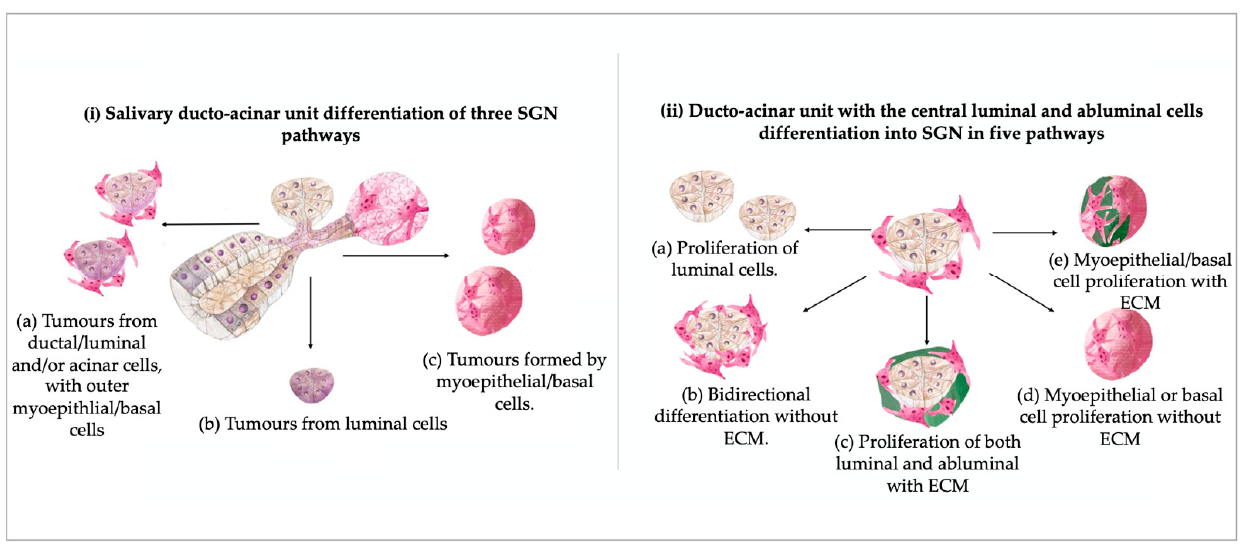
Figure 2. Schematic representation of the pathogenesis of SGN. ( A ) Histogenic concepts. ( B ) Morphogenic concepts. Reprinted from [2,5,6,13] with permission. Figure 2A depicts the four histogenic concepts that emphasize reserve cells of the salivary gland that replicate pathologically to form SGN (the cell type is highlighted in red for each theory): (i) Basal reserve cell theory–basal cells of excretory and intercalated ducts; (ii) pluripotent unicellular reserve cell theory–basal cells of the excretory duct; (iii) semi-pluripotent bicellular reserve cell theory–basal cells of the excretory duct and intercalated duct; (iv) multicellular theory–all mature acinar and basal cells. Figure 2B highlights the morphogenic concept that emphasizes the differentiation process and arrangement of tumor cells in SGN development: (i) Salivary ducto-acinar unit showing potential for differentiation of three SGN pathways: (a) tumors arising from combination of ductal/luminal and/or acinar cells, with outer myoepithelial/basal cells; (b) tumors mainly originating from luminal cells that may differentiate into non-specific ductal, acinar or goblet cells, and/or combination of these cells; (c) tumors almost entirely formed by myoepithelial/basal cells; or (ii) cross-section of the ducto-acinar unit with the central luminal (luminal/acinar) and surrounding abluminal cells (myoepithelial and basal cells) which can further differentiate into SGN: (a) proliferation of luminal cells; (b) bidirectional differentiation without extracellular matrix (ECM) materials; (c) proliferation of both luminal and abluminal cells with foci of extracellular matrix materials; (d) myoepithelial or basal cell proliferation without extracellular matrix materials; (e) myoepithelial or basal cell proliferation with extracellular matrix materials. The figure was adapted from Sreeja et al. 2014 and Jagdish 2014 [2,13].